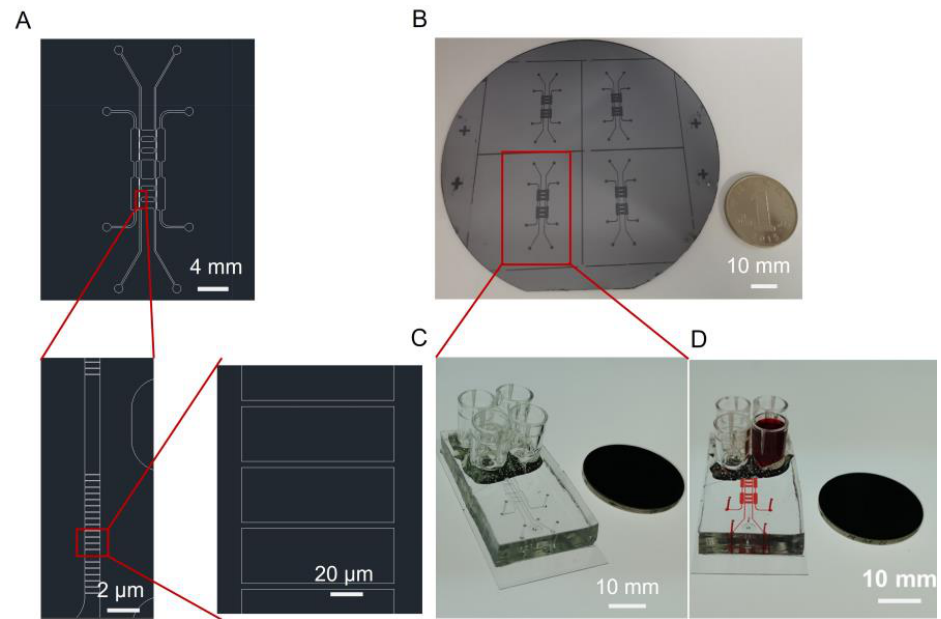
Figure 1. ( A ) Design drawing of the microfluidic chip. ( B ) The positive mode of the microfluidic chip on a silicon wafer. ( C ) Image of the microfluidic chip that consists of PDMS and cover glass. ( D ) The microfluidic chip with microchannels filled with red ink. There are two critical functional areas on the microfluidic chip: the air valve and the connection channels between macrophages and fibroblasts. When the air was introduced into microchannel c, the pressure was generated and subsequently caused the PDMS under microchannel c to press down. Hence, microchannel b was separated by the pressed PDMS, and the situation was called valve closed (Scheme 1A,C CLOSED). On the contrary, when the air was drawn away from microchannel c, the PDMS under the microchannel c returned to its original shape and the lower channel was connected again. The situation was called valve open (Scheme 1A,C OPEN). When the air valve was closed, the channel in the middle of the cell culture layer was separated (Figure 2A). NIH-3T3 cells were separated to simulate wound formation (Figure 2C). When the air valve was open, the channel was connected (Figure 2B). As shown in Figure 2D, the NIH-3T3 cells grew towards each other which was used to mimic wound healing in